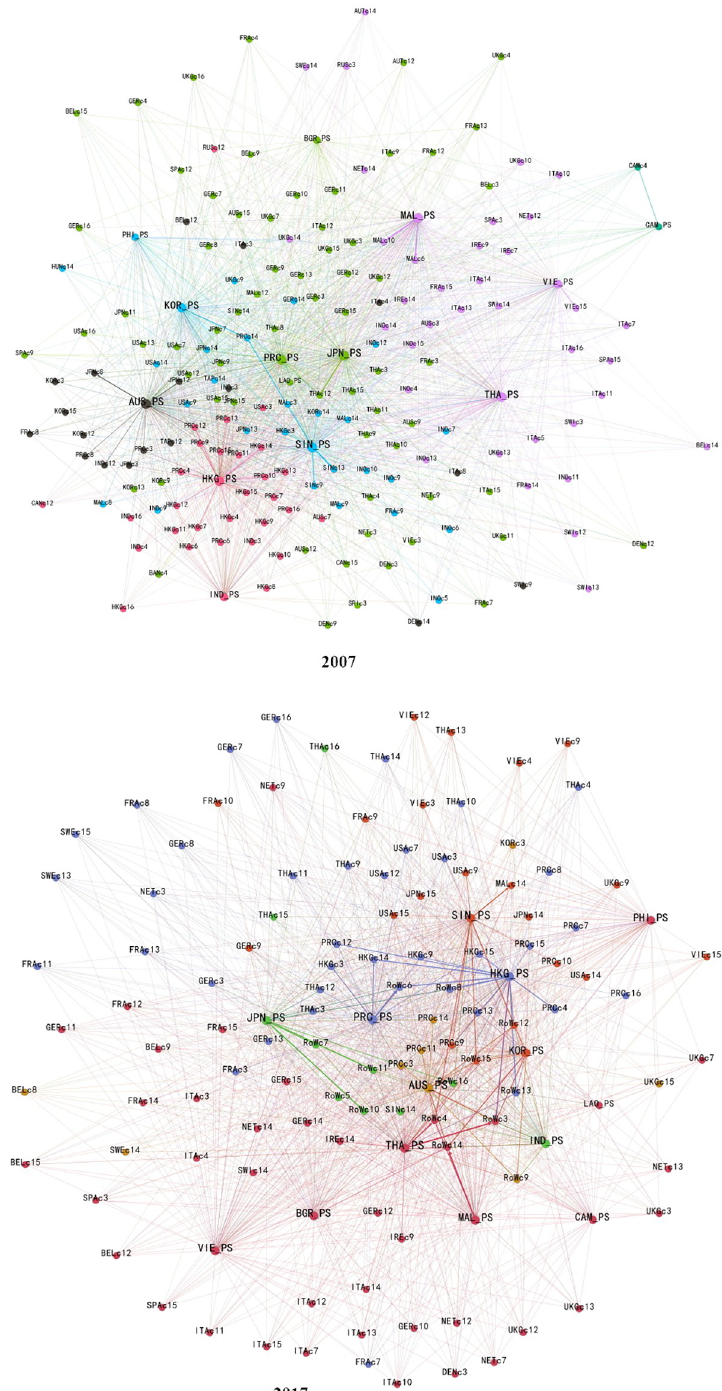
Fig 1. Comparison of the contribution of producer services from RCEP economies from 2007 to 2017. Source: ADB-MRIO database.